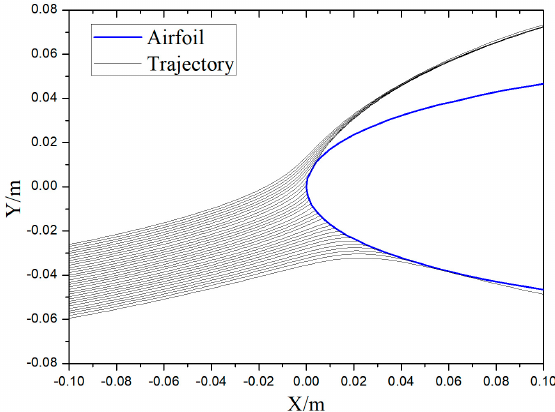
Figure 3. Droplet trajectories for the NACA0012 verification example.